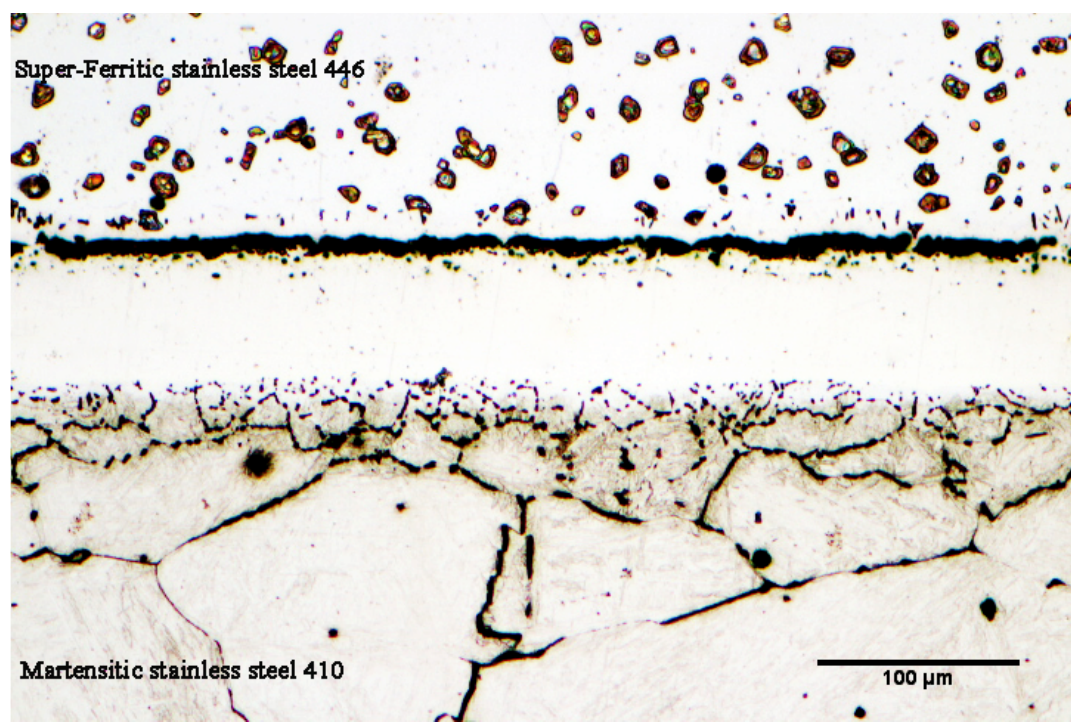
Figure 6. The microstructure of joint interface of the TLP-bonded sample at 1050 °C/60 min condition.